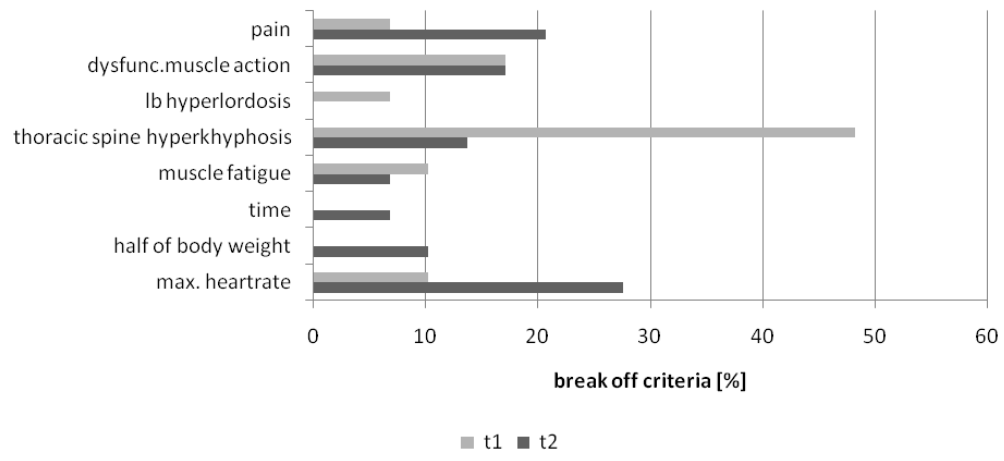
Figure 4. Pre-Post results break off criteria PILE-Test (t1 = pre-test; t2 = post-test) in the intervention group.